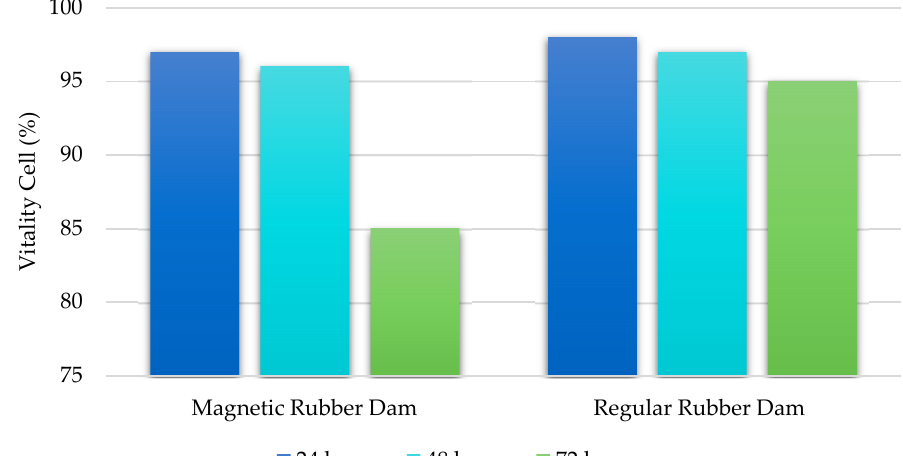
Figure 2. Percentage of vitality cell determined related to the control group.